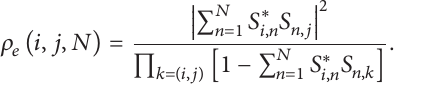
Figure 22: Simulated proposed MIMO antenna’s envelope correla- tion